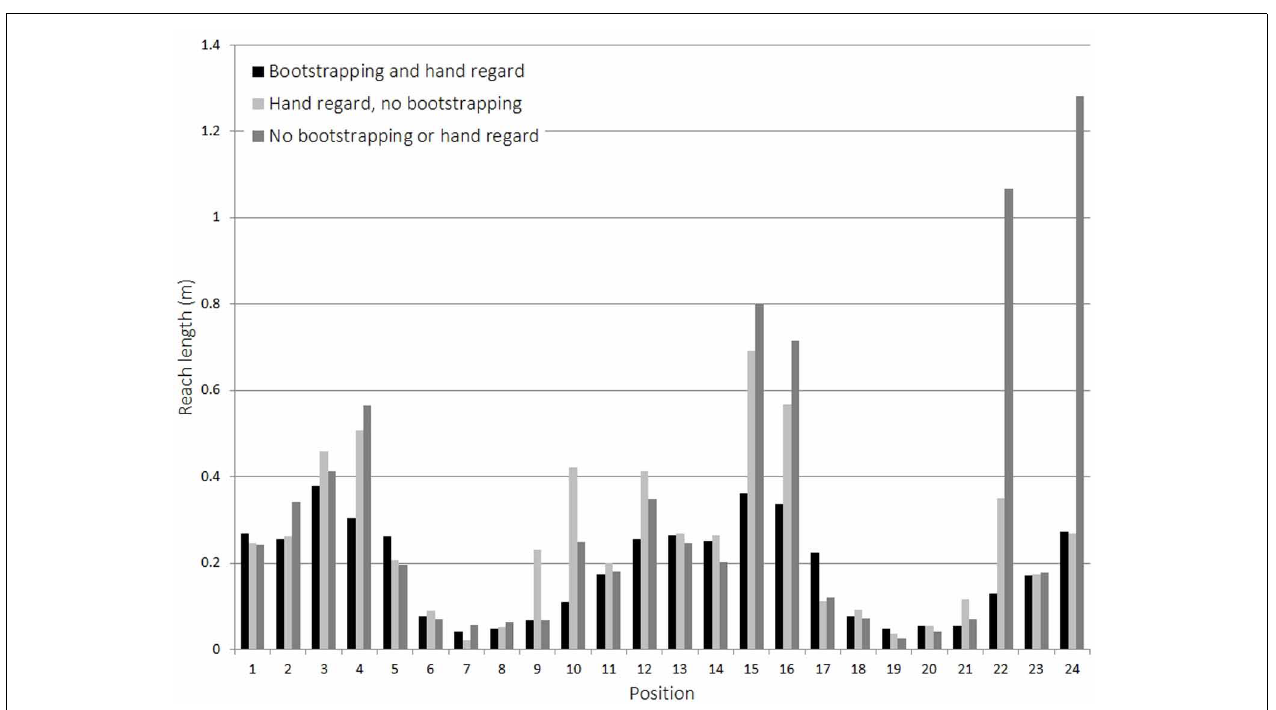
FIGURE 9 | Effect of bootstrapping on reach